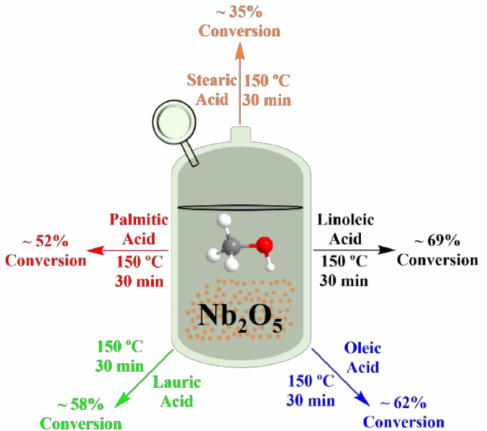
Figure 14. Different fatty acids esterification with Niobium oxide in anhydrous methyl alcohol. Reaction conditions: alcohol: fatty acid molar ratio (1.2), catalyst (20 wt% in relation to the fatty acid mass), temperature (150 ◦ C), time (30 min) (adapted from